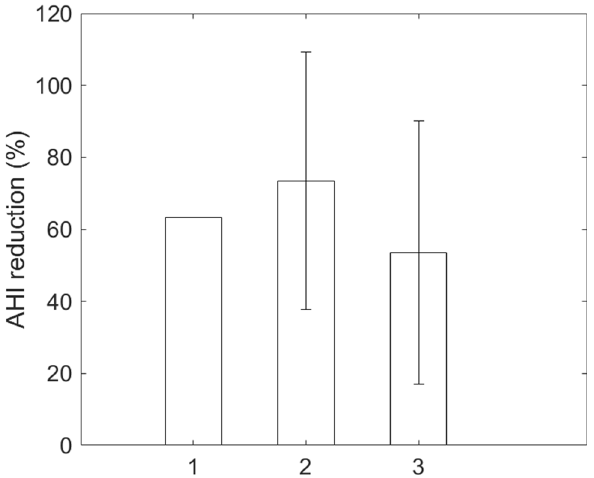
Figure 2. Reduction of apnea–hypopnea index (AHI) in different Friedman anatomical stage.